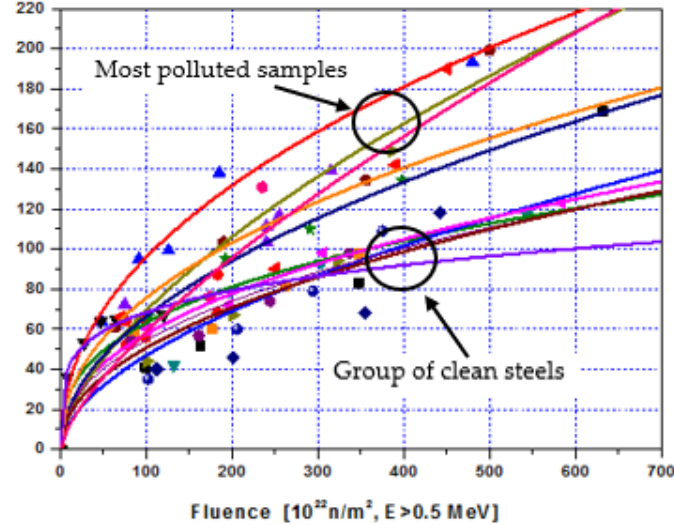
Figure 3. 15Kh2MFA forging transition temperature change in the function of the neutron fluence. It shows the effect of the chemical composition: the ductile brittle transition temperature reduced (measured by Charpy impact test using 41J criteria) decreased by about 50% using clean version of the steel [7].